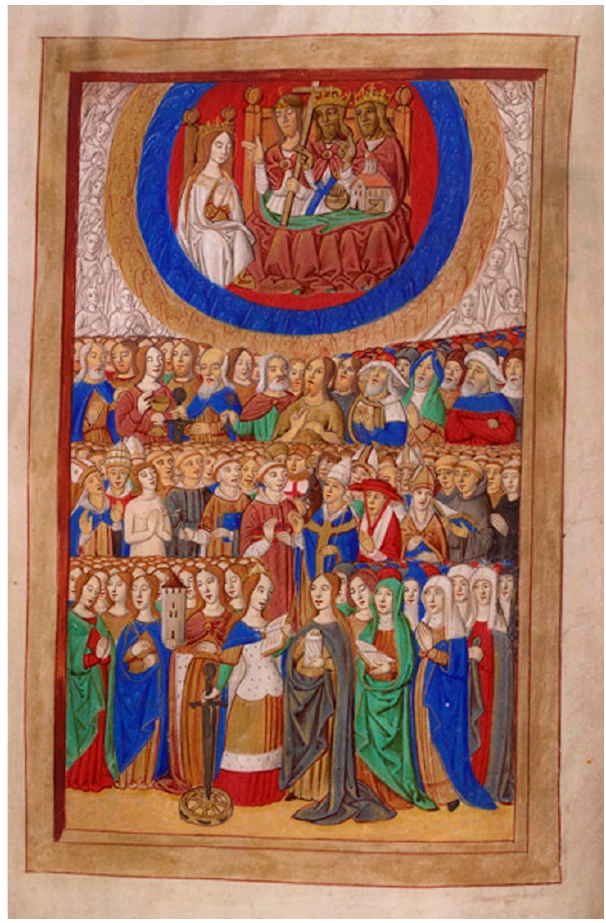
Figure 10. The Coronation of the Virgin before the Trinity, the Hours of Thomas Butler, f.55v, © British Library Board.